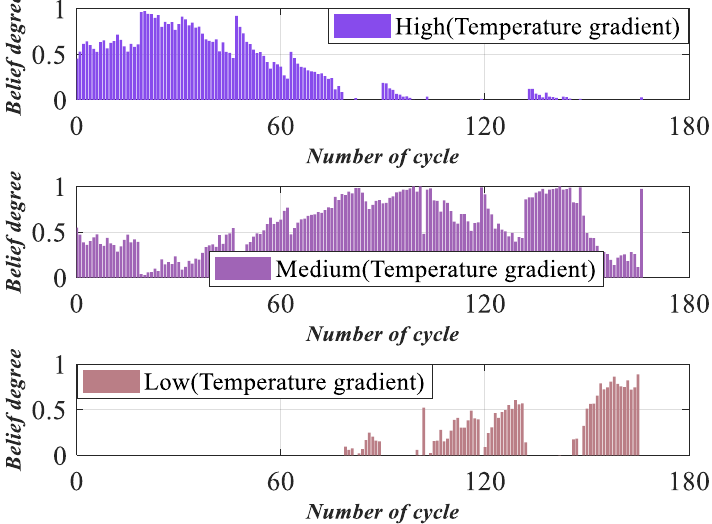
Figure 14. Belief distributions of temperature gradient.